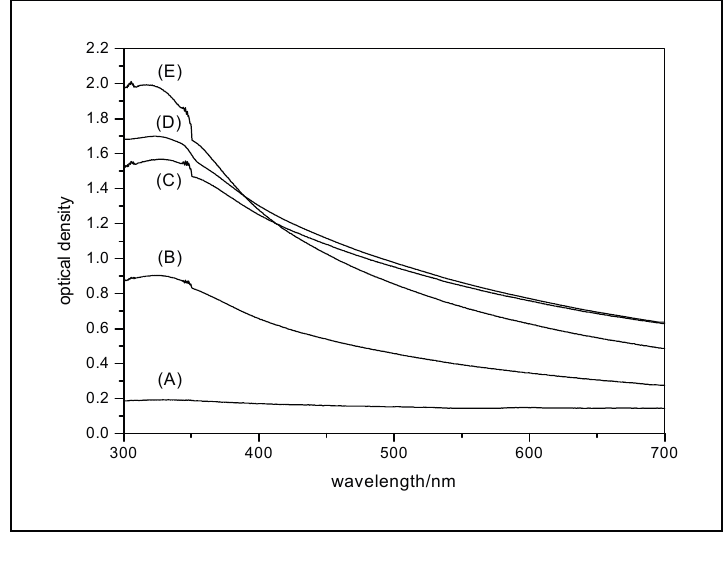
Figure 14. ( a ) Optical transmission curves measured on (A) unmilled 140 m 2 ·g − 1 rutile, and the same rutile milled for (B) 7.5 minute, (C) 15 minutes and (E) 30 minutes. Curve D was measured on a 15-minute milled and diluted sample that had been left to stand for the duration of a typical oxidation experiment prior to making the measurement; ( b ) The time dependence of propanone formation during the photocatalytic oxidation of propan-2-ol by the same 140 m 2 ·g − 1 rutile before sand-milling ● , and after milling for 7.5 ■ , 15 ▲ and 30 ×, minutes. Reprinted from Egerton & Tooley, J. Phys. Chem. B 2004 , 108 , 5066–5072 [36] with